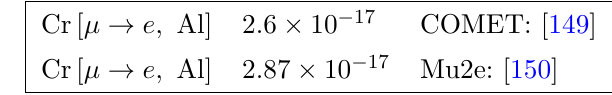
Table 10. Current experimental upper bound on µ → e conversion in Gold.